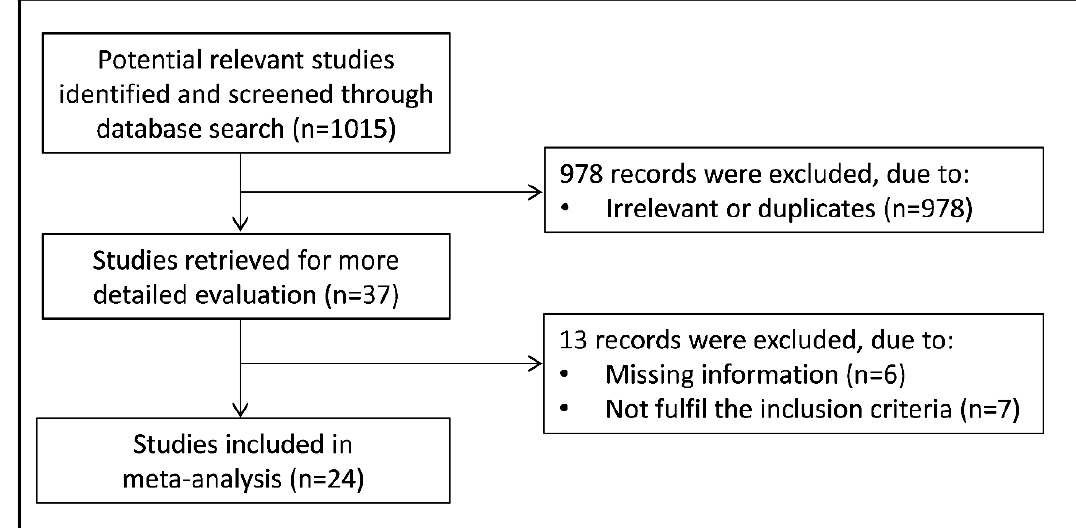
Figure 1. Flow chart of study selection.